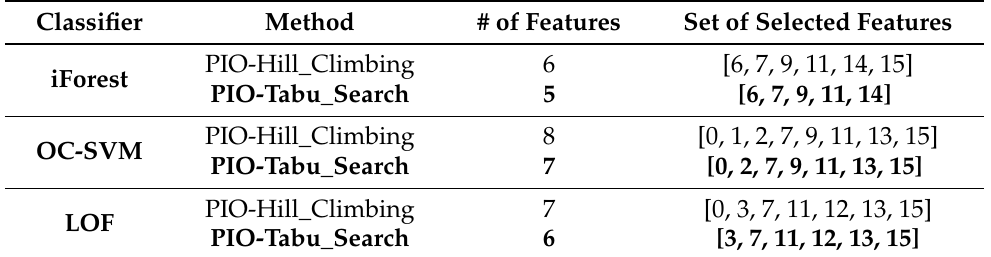
Table 7. The selected features from [32] dataset by LS_PIO based on different classifiers and local search methods.